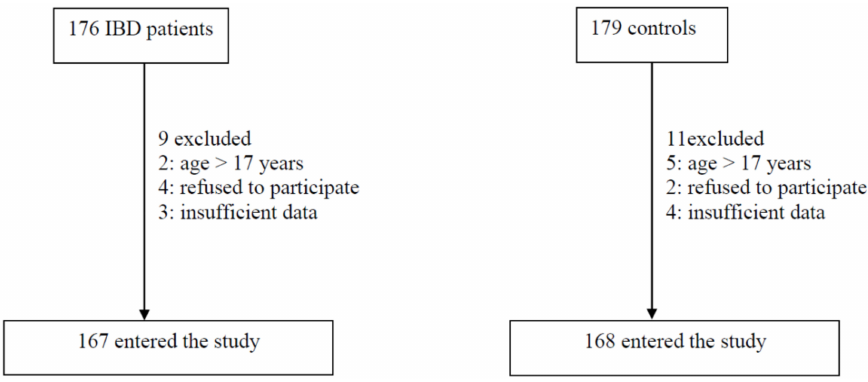
Figure 1. Flowchart reporting the process of patient